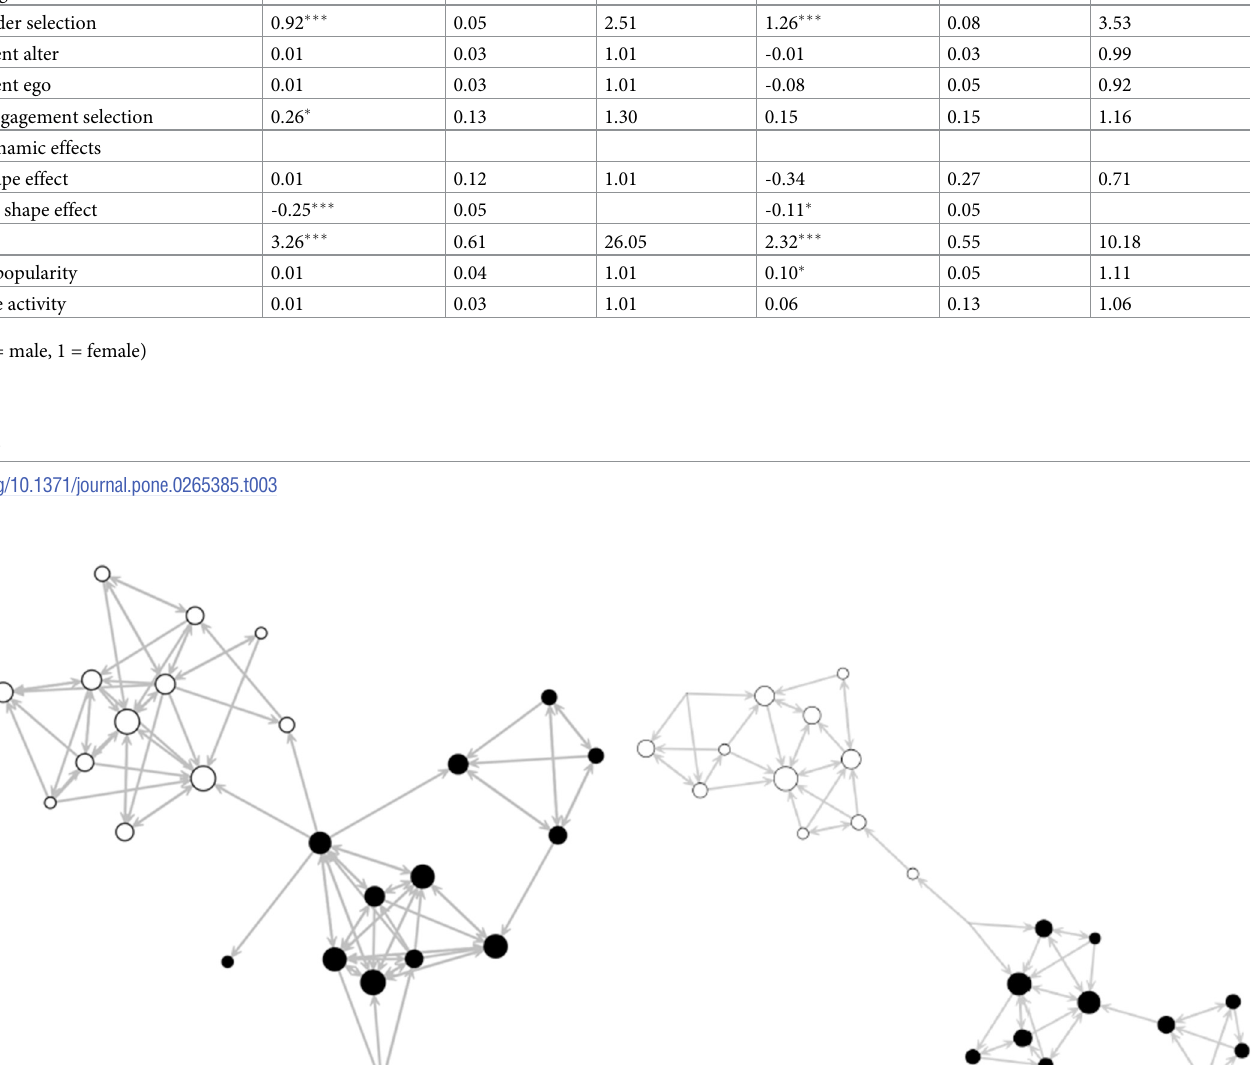
PLOS ONE | https://doi.org/10.1371/journal.pone.0265385 March 24,